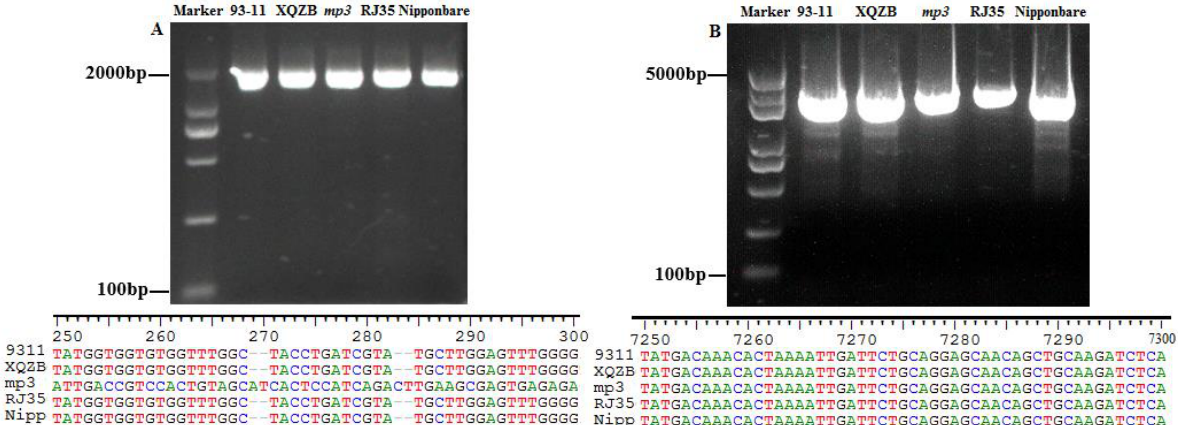
Figure 7. Sequencing of the promoter and coding sequence of OsMADS1/ LOC_Os03g11614 in mutant mp3 and wild-type rice. ( A ) Sequencing of the promoter sequence of OsMADS1/ LOC_Os03g11614 in mutant mp3 and wild-type rice by GS64 amplified. ( B ) Sequencing of coding sequence of OsMADS1/ LOC_Os03g11614 in mutant mp3 and wild -type rice by GS9 amplified.